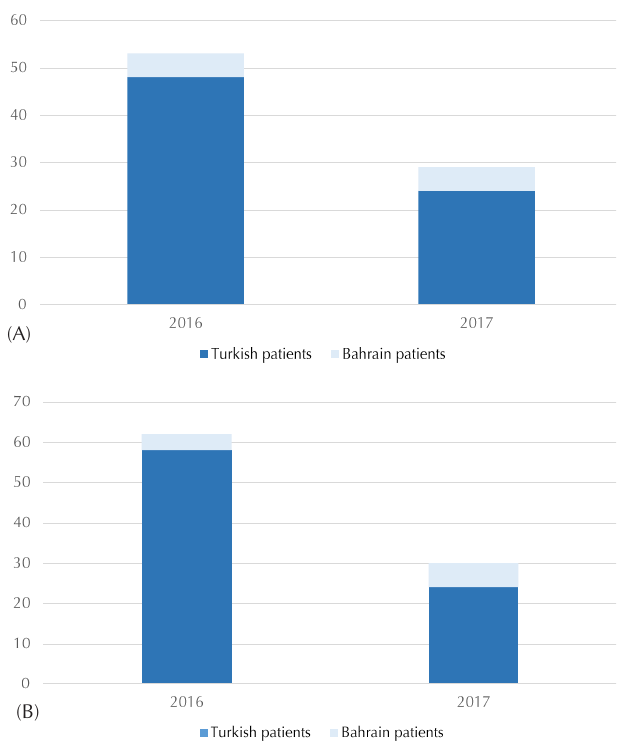
Figure 3 . Total Number of Allogeneic (a) and Autologous (b) Stem Cell Transplantations and Number of International Transplant Patients Since 2016.